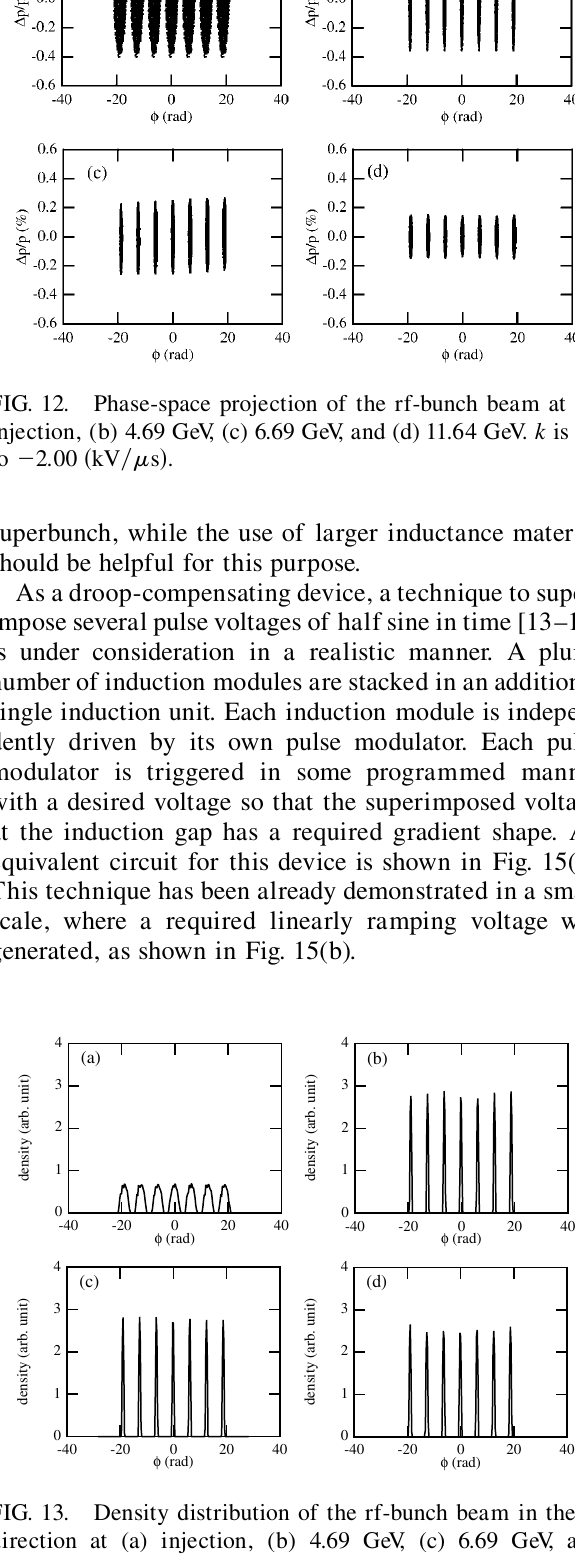
FIG. 13. Density distribution of the rf-bunch beam in the (cid:23) direction at (a) injection, (b) 4.69 GeV, (c) 6.69 GeV, and (d) 11.64 GeV. k is set to (cid:5) 2 : 00 (cid:1) kV =(cid:22) s (cid:2)